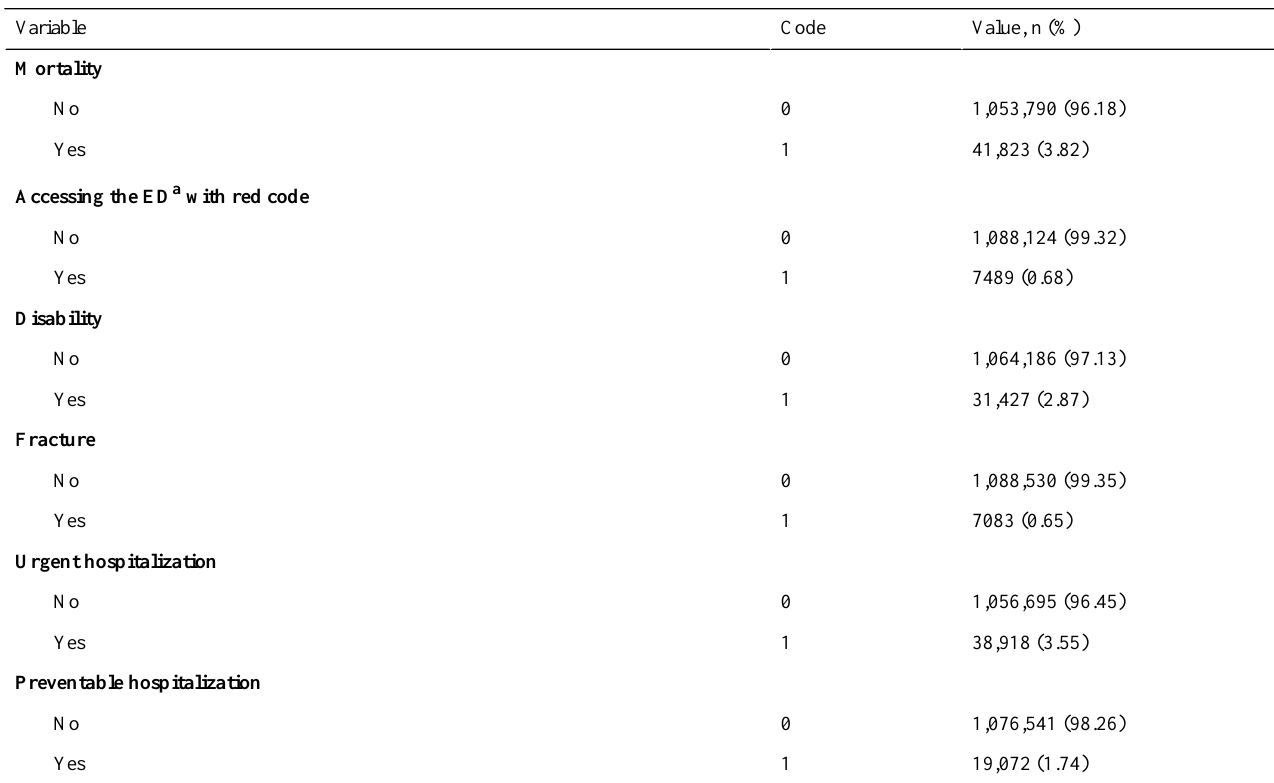
Table 1. Description of output variables in the